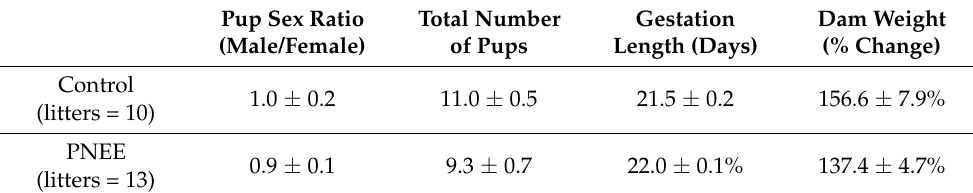
Figure 1. Choline treatment did not significantly affect body weight. ( A ). Cartoon outlining the experimental timeline for PNEE, choline administration, and electrophysiology. The average body weights (g) across the experimental timeline are shown for both ( B ) male offspring ( n = 10–12 animals per group) and ( C ) female offspring ( n = 6–14 animals per group). Table 1. Demographics of Control and PNEE Litters.